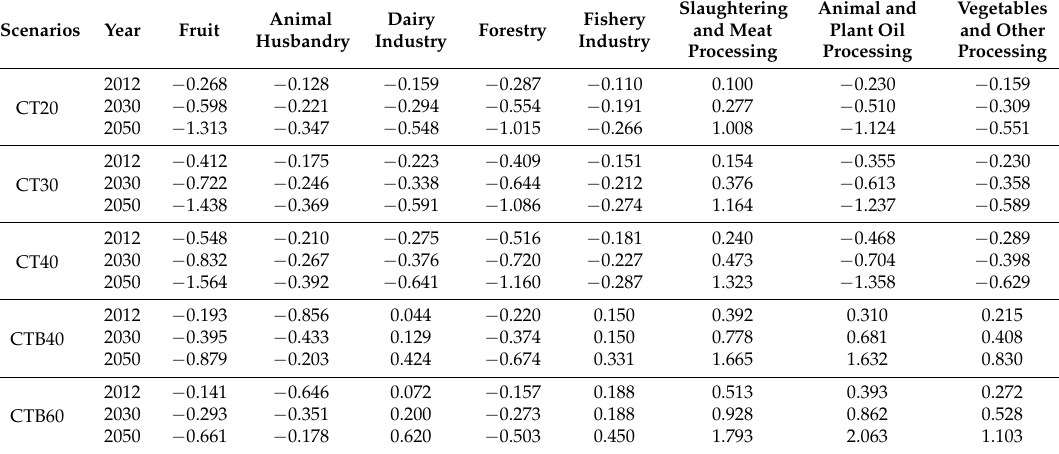
Table 9. The changes in outputs in agriculture-related sectors under different scenarios compared with the BAU scenario (%) (from fruit to vegetables and other